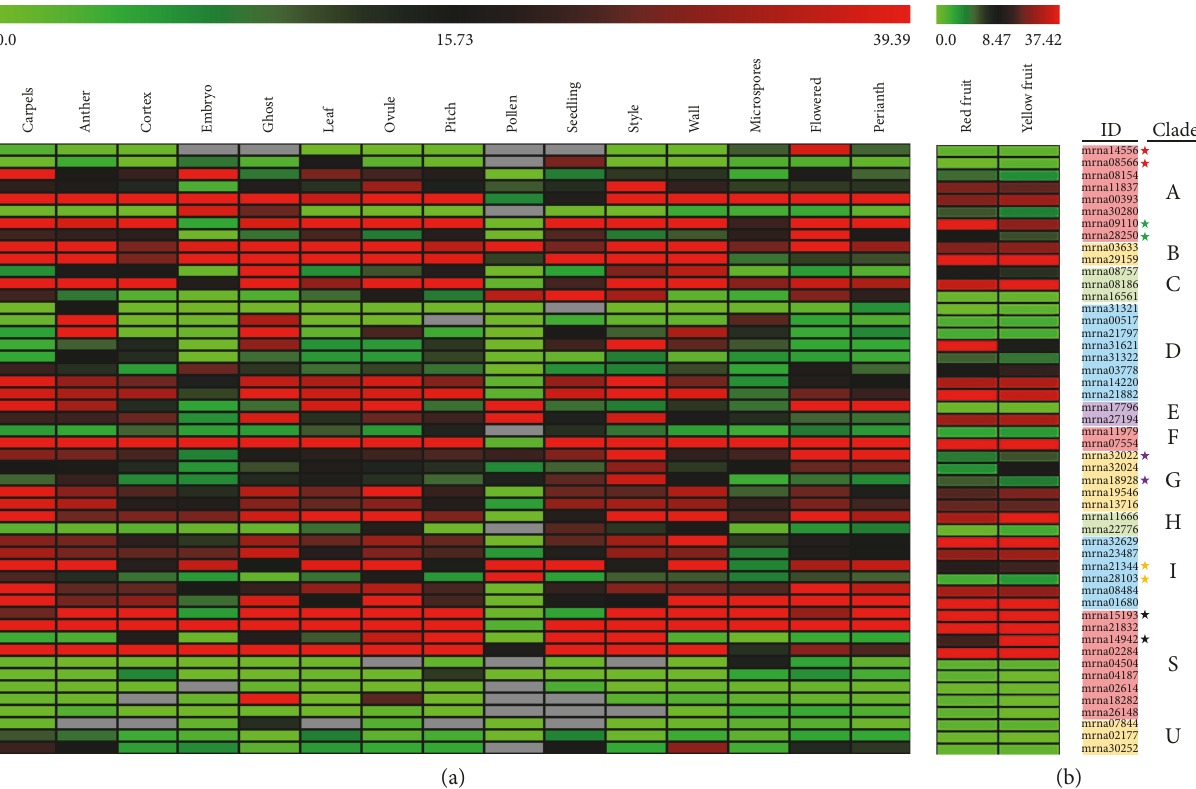
Figure 5: Heatmap of all FvbZIP genes expressed in di ff erent tissues (a) and red/yellow fruits (b). This heatmap was generated based on the RT-PCR data (normalized) using the MeV software. Green indicates low expression, black indicates intermediate expression, and red indicates high expression.